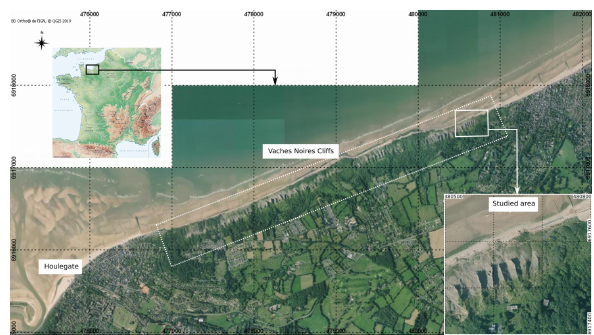
Figure 4. Example of thermal images obtained during the acquisition.